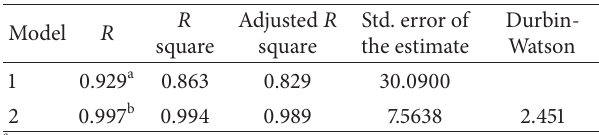
Table 12: Model Summary c . Table 13: ANOVA c . Model Sum of squares df Mean square 𝐹